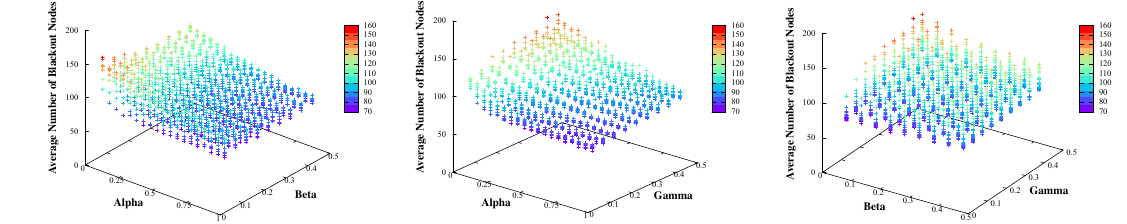
Figure 6. The average number of blackout nodes based on α , β , and γ